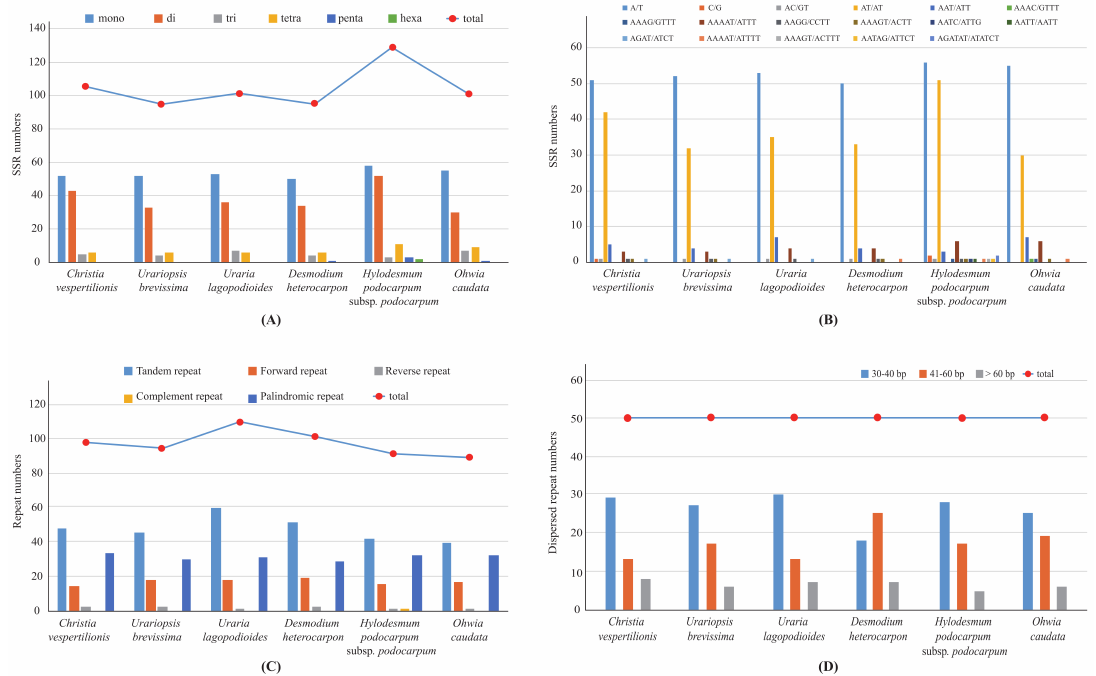
Figure4. Thenumber andtypeof simplesequencerepeats(SSRs)and repeat sequencesinthe chloroplast genomes of six Desmodieae species. ( A ) Frequency of six SSR types, ( B ) Frequency of SSR motifs in di ff erent repeat class types, ( C ) Frequency of five repeat types, ( D ) Frequency of dispersed repeat sequences by